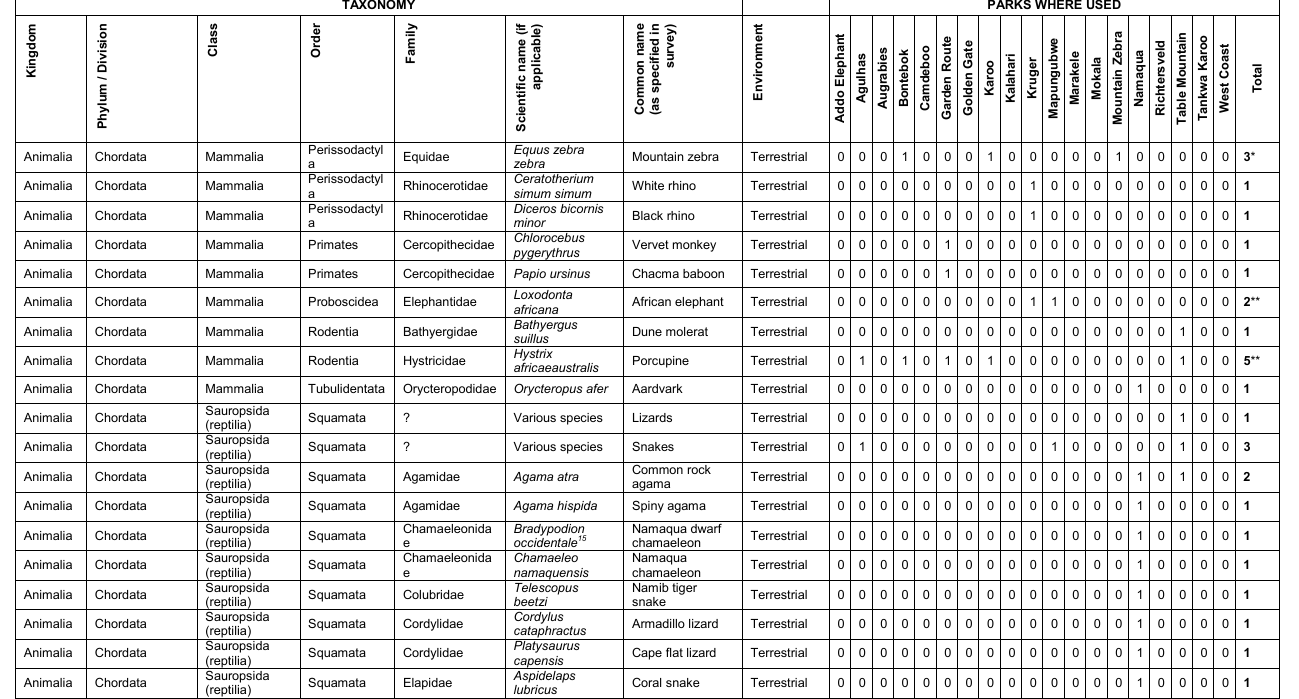
15 Synonym Bradypodion ventrale occidentale, Lophosaura ventralis